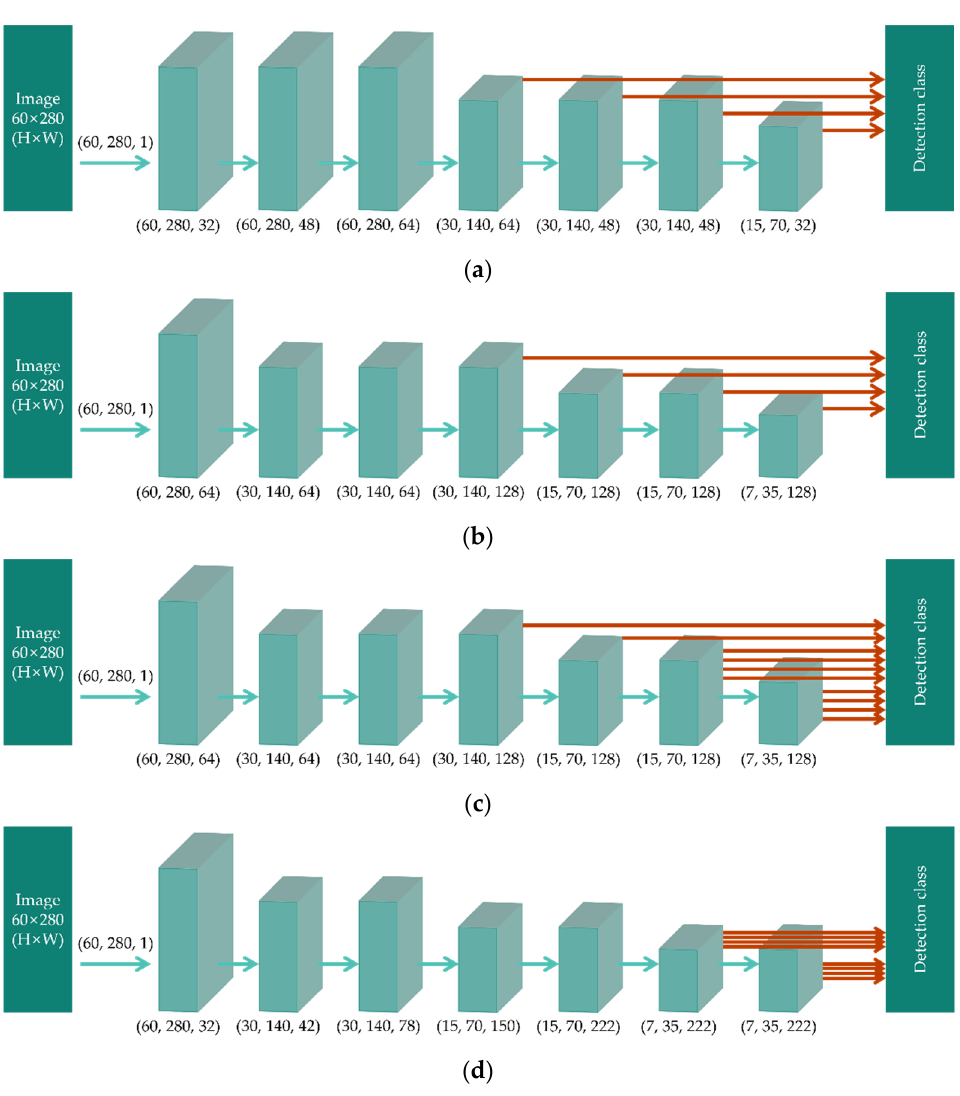
Figure 7. Modified architectures: ( a ) Version 1; ( b ) Version 2; ( c ) Version 3; ( d ) Version 4.